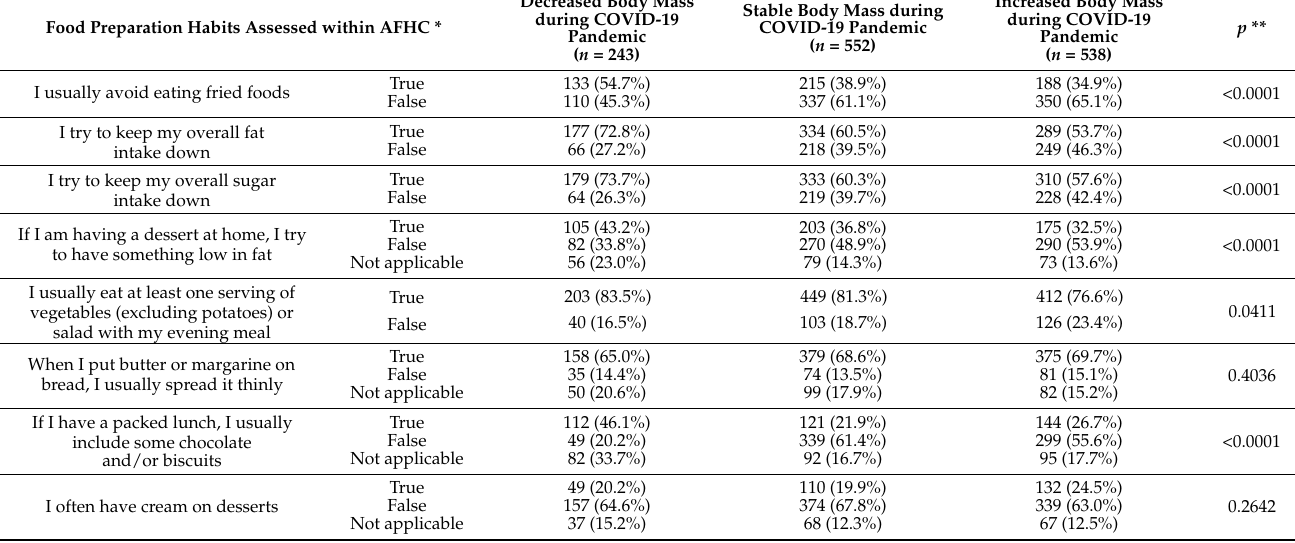
Table 5. The food preparation habits assessed while using Adolescents’ Food Habits Checklist (AFHC) in the period during the COVID-19 pandemic, as declared by the adolescents from the Diet and Activity of Youth during COVID-19 (DAY-19) Study cohort ( n = 1333) in sub-groups of adolescents declaring decreased, stable, and increased body mass during the COVID-19